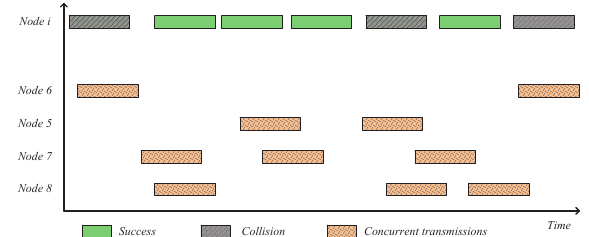
Figure 3. Effect of accumulative interferences on transmission of node i to node j